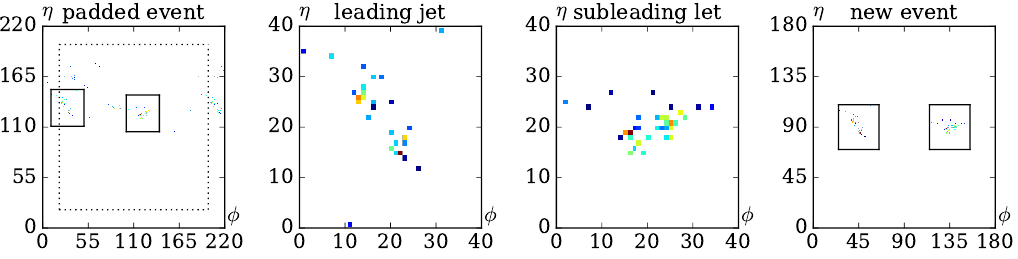
Figure 3: Processing of the event images to a pair of top